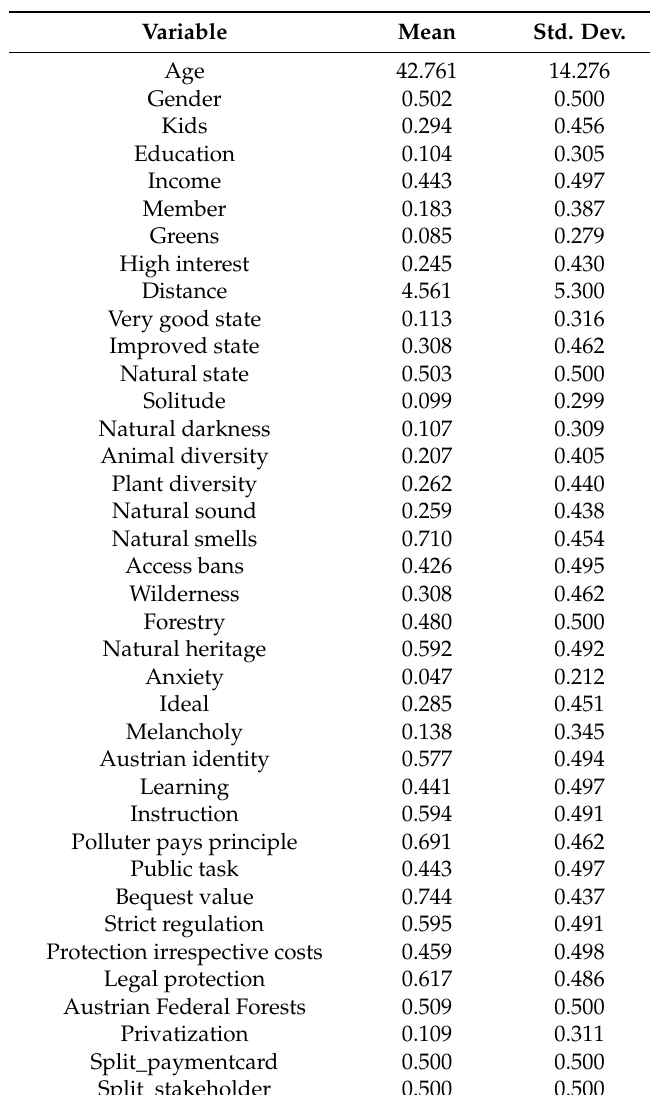
Table 3. Summary statistics of the explanatory